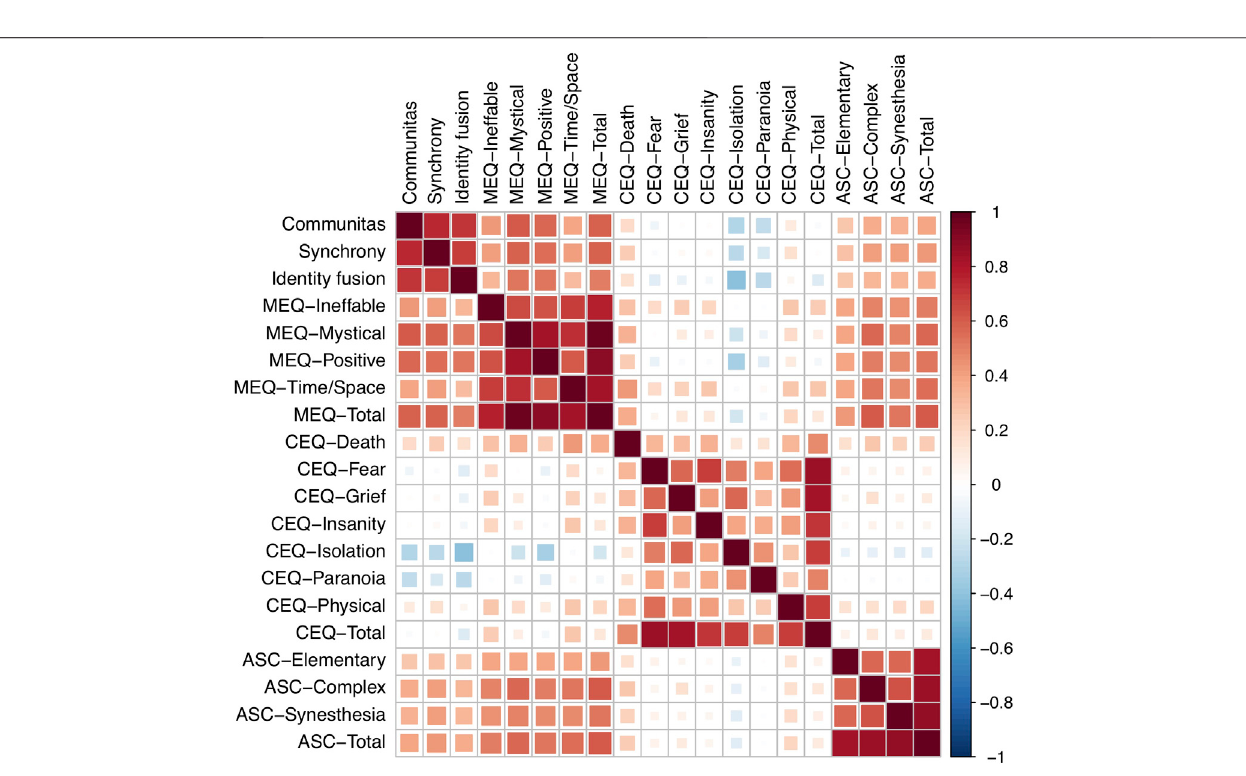
FIGURE3| Correlationheatmapofsubjectiveexperiencemeasurestakenonthedayafter N (cid:1) 720psychedelicsessions.Colorintensityandsquaresizesareboth proportionaltothe(Pearson)correlationvalue.MEQ:MysticalExperienceQuestionnaire;CEQ:ChallengingExperienceQuestionnaire;ASC:Visualexperiencesubscales of the Altered States of Consciousness